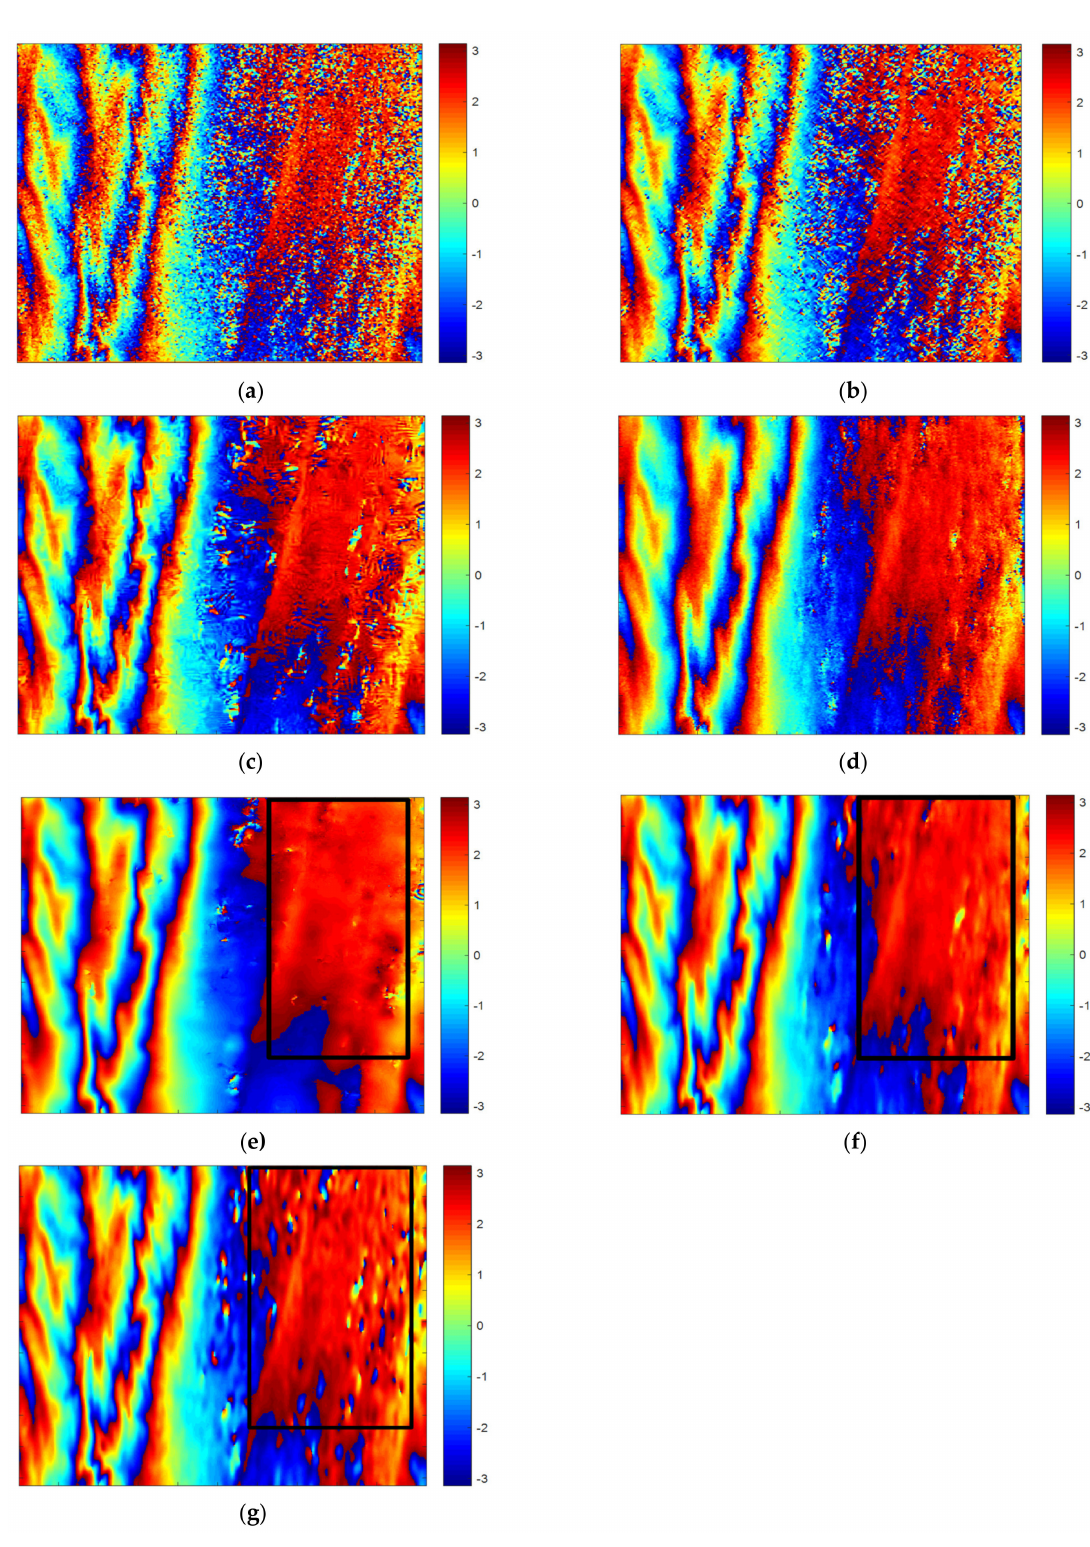
Figure 11. The filtering results obtained by processing Figure 9b using the seven methods: ( a ) the filtering interferogram of the Lee filter; ( b ) the filtering interferogram of the Goldstein filter; ( c ) the filtering interferogram of the InSAR-BM3D filter; ( d ) the filtering interferogram of ISTA; ( e ) the filtering interferogram of the Phi-Net; ( f ) the filtering interferogram of the PFNet; ( g ) filtering interferogram of the proposed